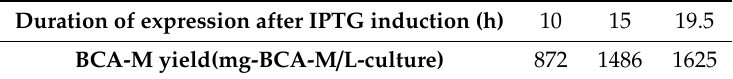
Table 2. BCA-M yield and expression e ffi ciency with di ff erent duration of expression in the pO 2 stat fermentation system.